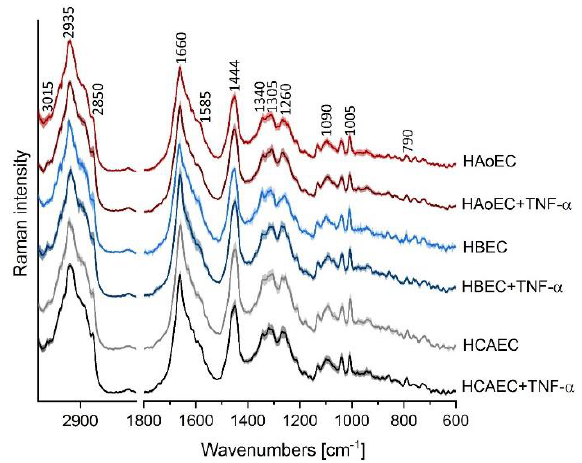
Figure 3. Raman spectral profiles of endothelial cells of various origin. Averaged Raman spectra from all measurements with a standard deviation at each data point of HAoEC (red), human brain microvascular endothelial cells (HBEC-5i, blue) and human coronary artery endothelial cells (HCAEC, gray) as control cells and after TNF- α treatment (darker colored spectra). 2.2. Endothelial Cells of Different Vascular Beds Visualized after Treatment of Astaxanthin EC of different origin, human aortic endothelial cells (HAoEC), human brain microvascular endothelial cells (HBEC-5i) and human coronary artery endothelial cells (HCAEC), were subjected to